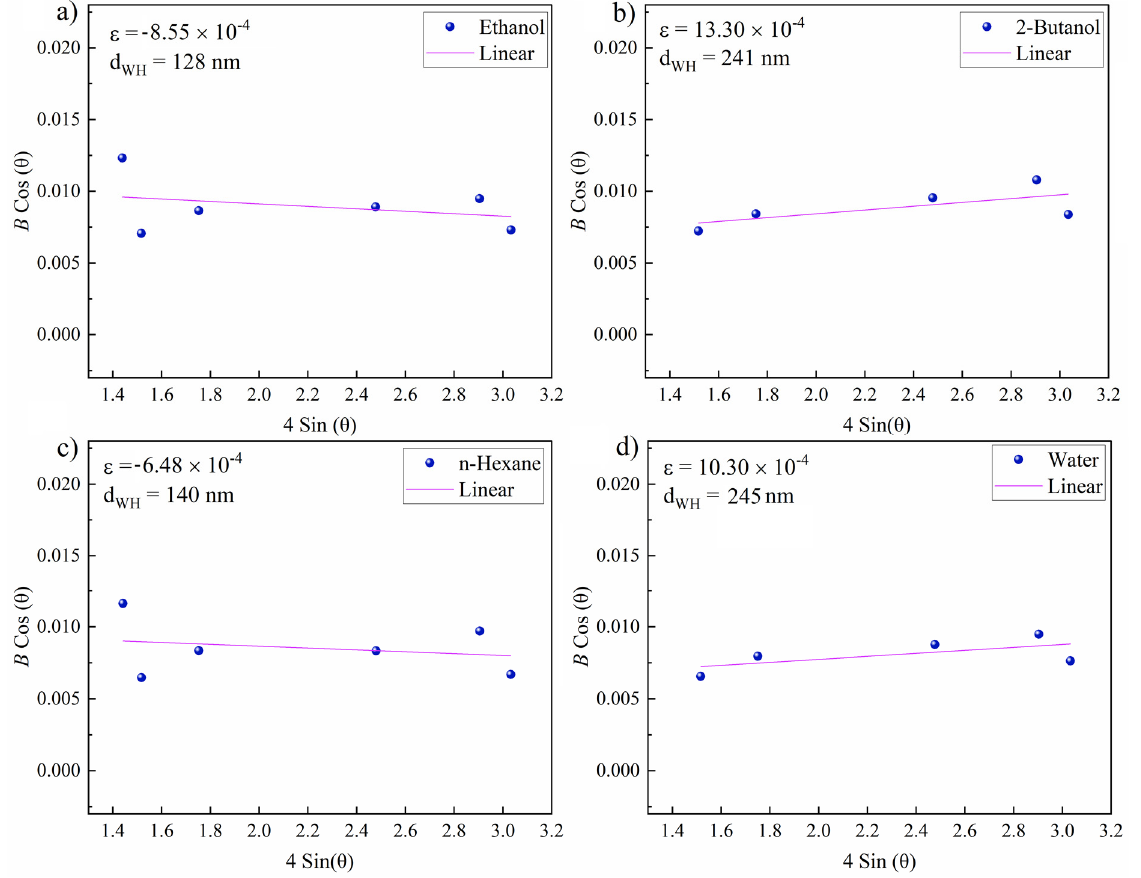
Figure 9. Williamson–Hall plots of femtosecond-laser-ablated areas near craters on the NiAu sample ( N = 1000, 1 kHz, E = 250 µ J). Resulting microstrain ( ε ) and grain size (d WH ) for NiAu ablated in ( a ) ethanol; ( b ) 2-butanol; ( c ) n-hexane; and ( d ) water.